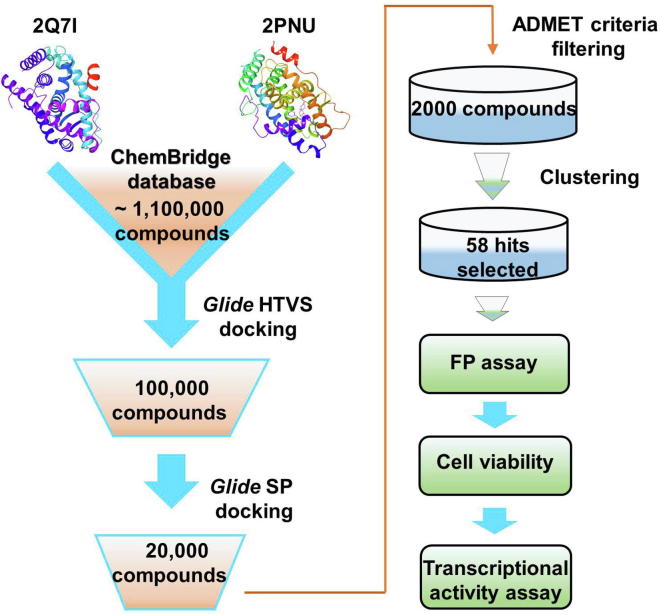
The workflow of the docking-based virtual screening and bioassay verificationBased on the structures of AR-LBD in complex with testosterone (PDB ID: 2Q71) and EM-5744 (PDB ID: 2PNU), respectively, 58 compounds were finally selected from the ChemBridge database sequentially by Glide HTVS docking, Glide SP, ADMET criteria, as well as clustering, and then subjected to bioassays. AR-LBD, ligand binding domain of androgen receptor; HTVS, high-throughput virtual screening; SP, standard precision; ADMET, absorption, distribution, metabolism, excretion, and toxicity.